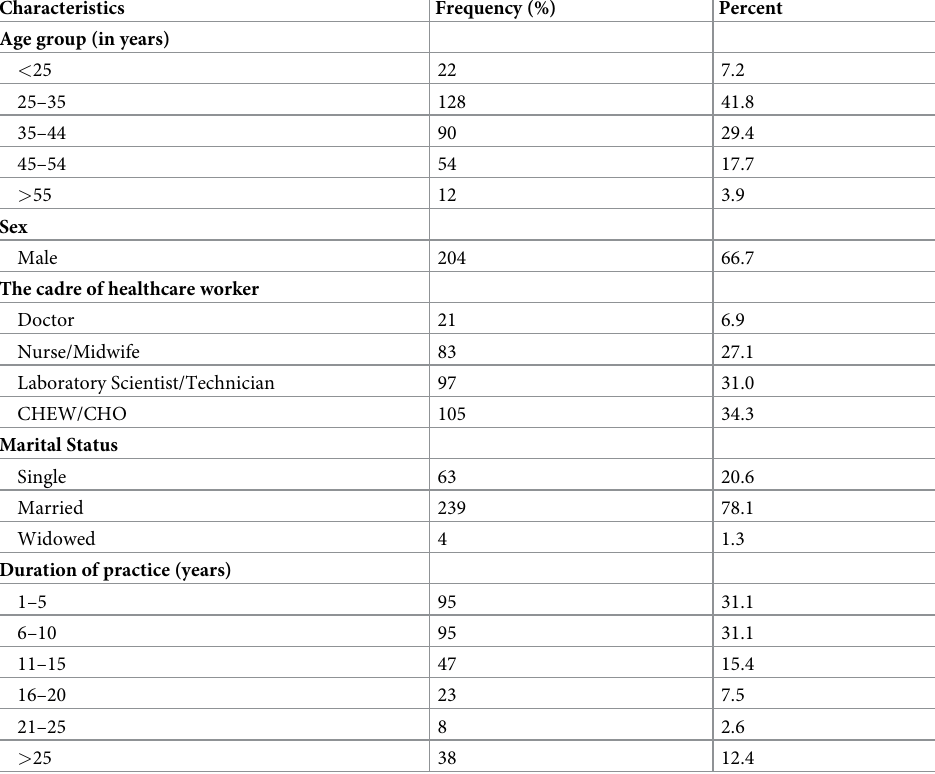
Table 1. Frequency distribution of socio-demographic characteristics of the respondents (N = 306).